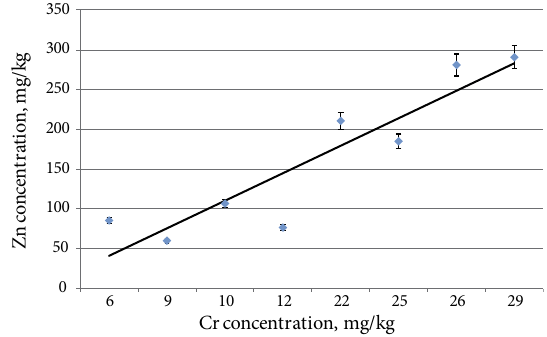
Fig. 2. Relationship between zinc and chromium concentrations in sweep sand